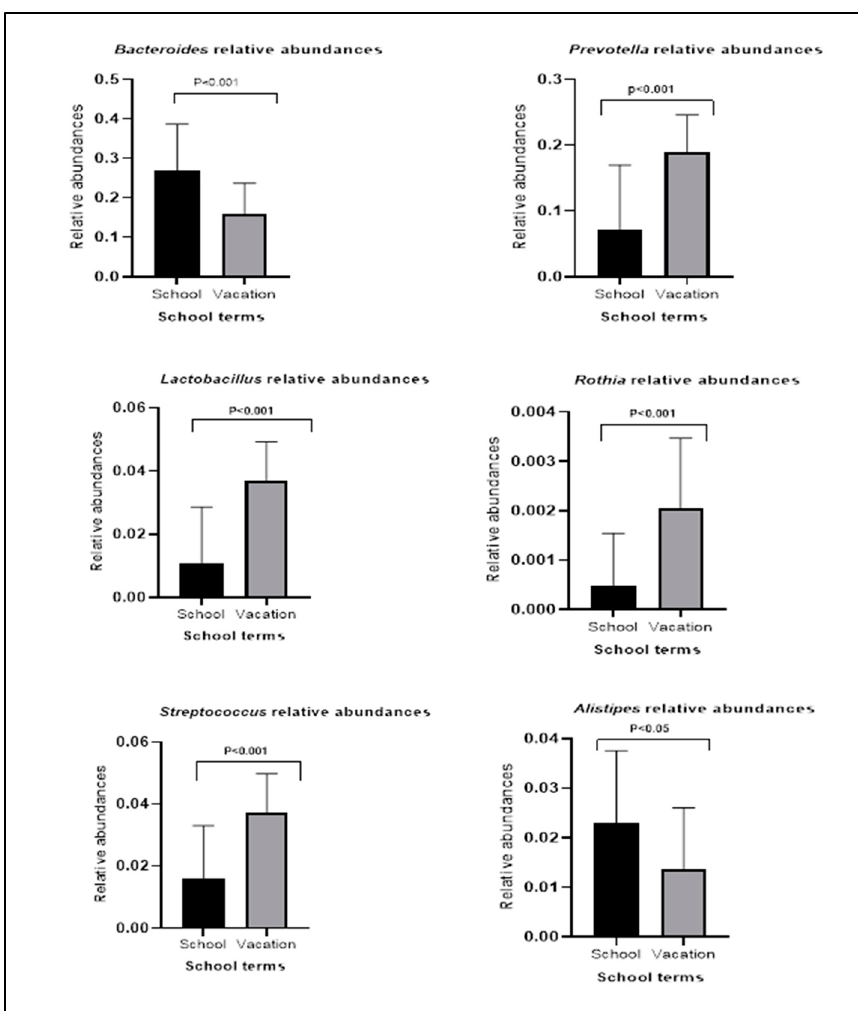
Figure 2. The relative abundance differences of different bacterial species in the control in school and vacation terms ( p < 0.05 was considered significant). Mann–Whitney U test was used to compare the relative abundances in the control group ( p < 0.05 was considered significant).